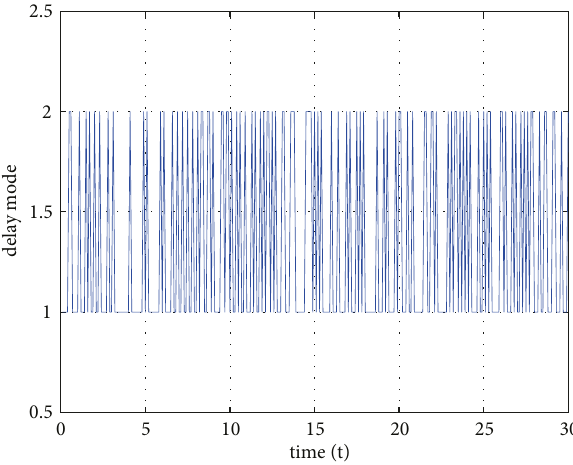
Figure 2: Group 1: the mode of time